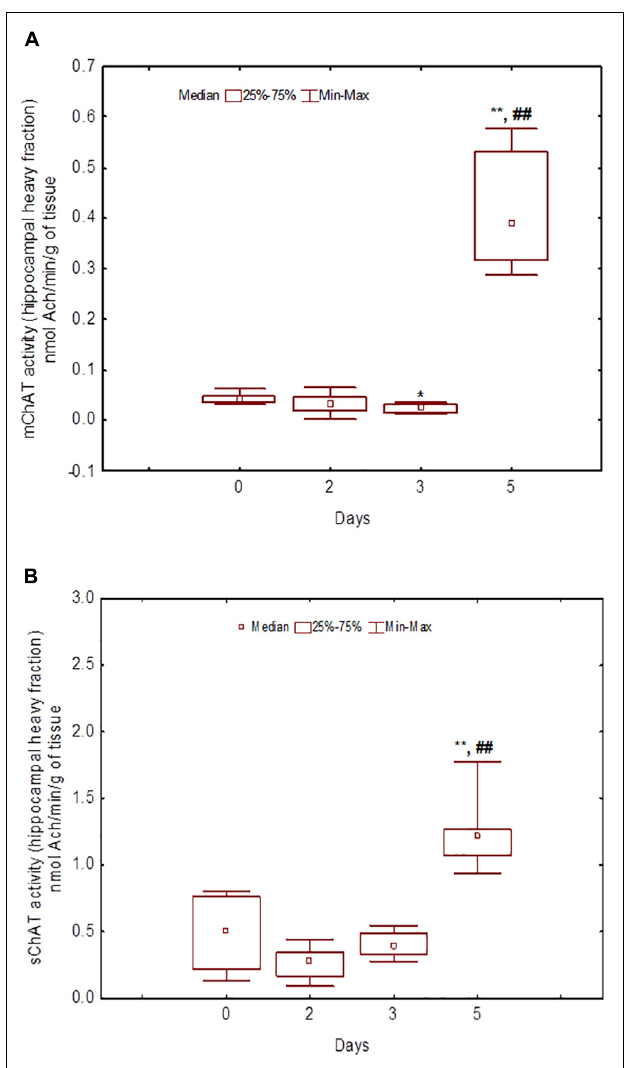
FIGURE 8 | Choline acetyltransferase (ChAT) activity in heavy synaptosomal sub-fractions from the hippocampus in naïve rats (day 0) and after 2, 3, or 5 days of training in the Morris water maze (MWM). (A) mChAT from heavy synaptosomal fraction, (B) sChAT from heavy synaptosomal fraction, * p < 0.05 and ** p < 0.01 relative to naïve rats. ## p < 0.01 relative to the previous time